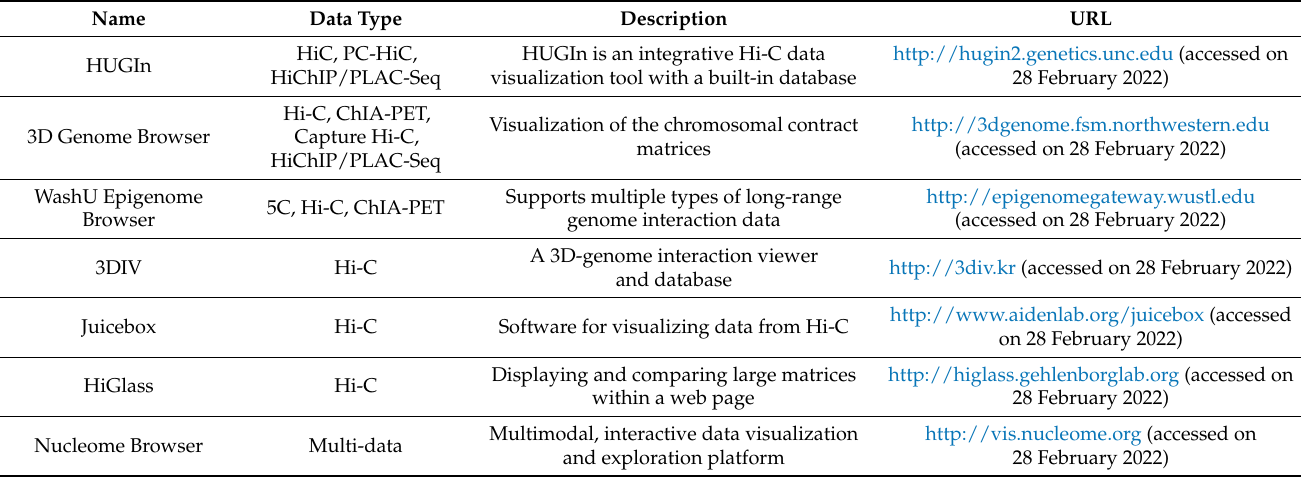
Table 2. Software.